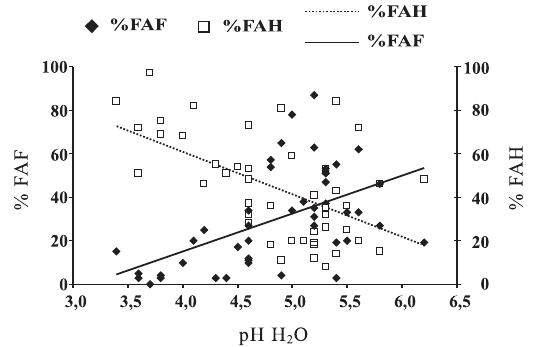
Figura 1. Diagrama de dispersão dos valores de pH com a %FAF e